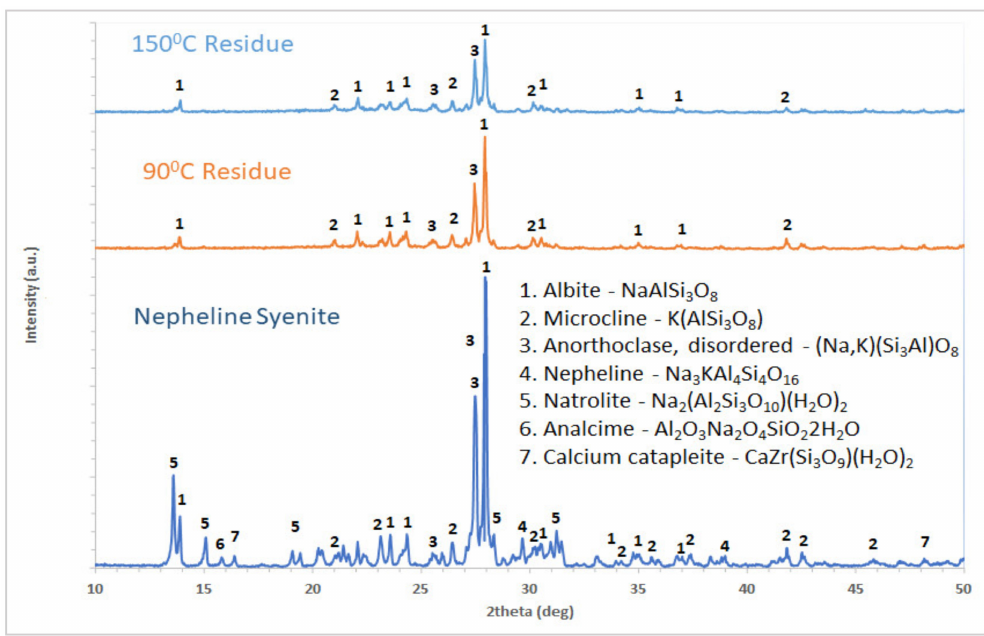
Figure 6. Powder X-ray diffractogram of nepheline syenite and leaching residues of 90 and 150 ◦